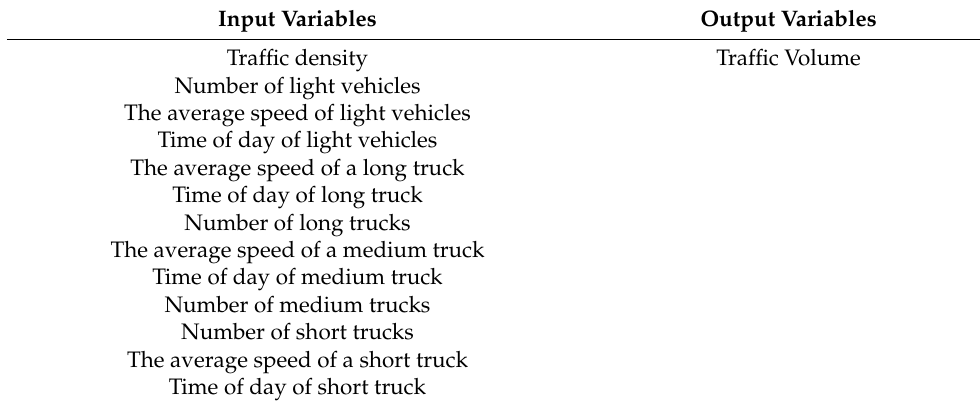
Table 1. Categorization of the traffic datasets into inputs and output.